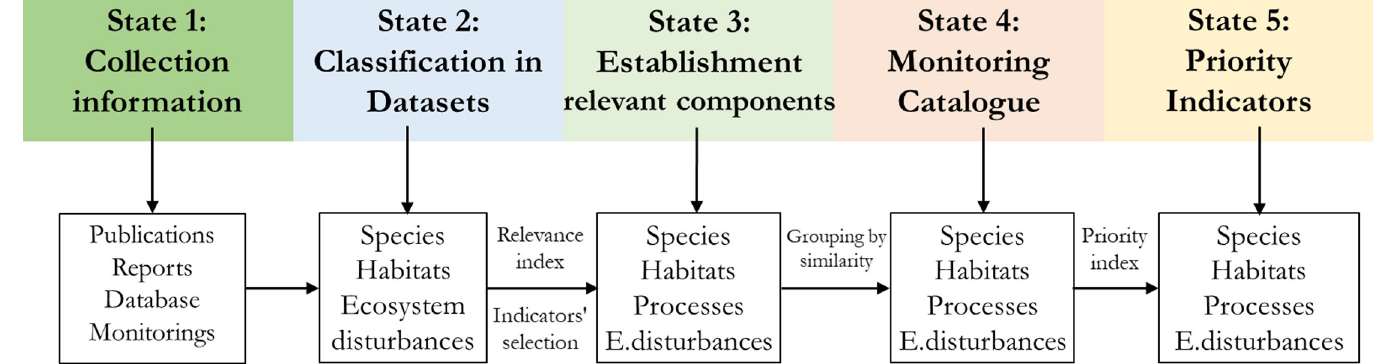
Fig 1. The work schedule for select priority indicators. The work schedule carried out for the selection of Priority indicators and its long-term monitoring program respects the following states: (1) search of published or unpublished information on the species, habitats, and biological communities present in the action scope; (2) classification of the components of biodiversity in candidates of species, habitats, and ecosystem disturbances; (3) establishment of and Relevant components catalogue of species, habitats, ecological processes and ecosystem disturbances employing the assessment with an Index of relevance, and make an ecological network to determine the Relevant components of the local ecological process; (4) creation of a Monitoring Catalogue of candidates; and (5) establishment of the Priority indicators by a quantitative Priority index.